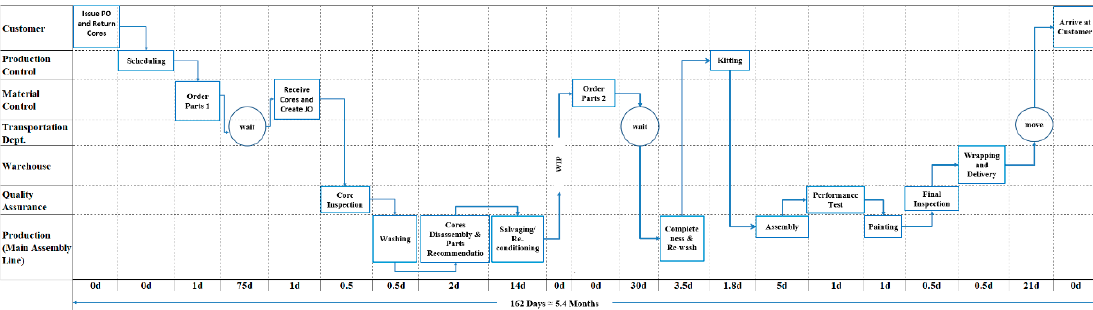
Figure 2. A time function map of the remanufacturing activities.